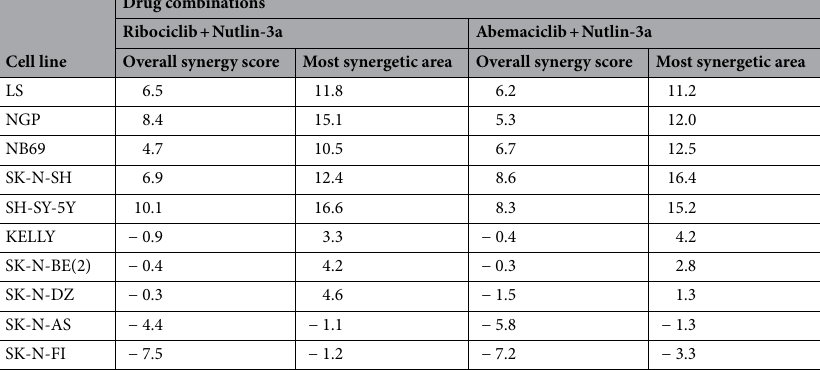
Table 3. Synergy scores after 72 h of combinational treatment.